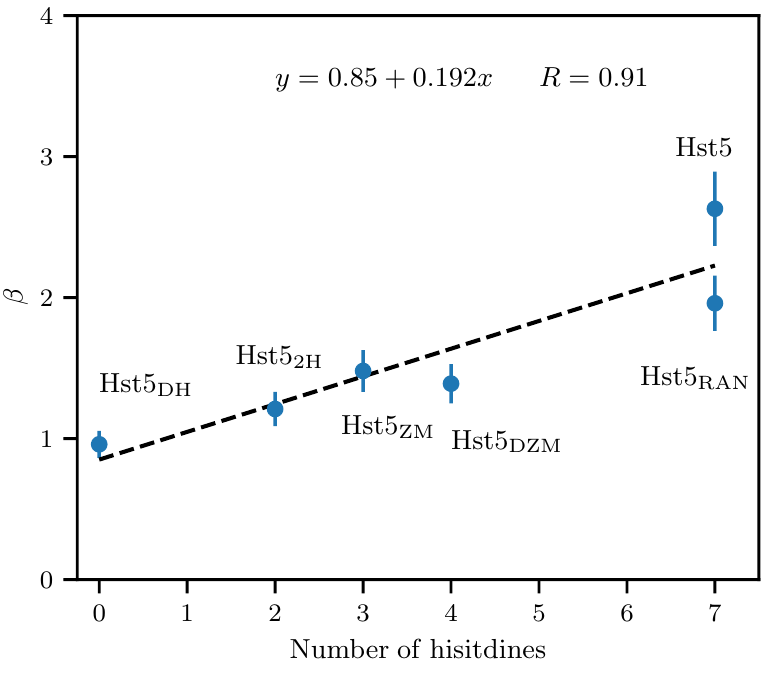
Figure 6. Correlation between the number of histidines and oligomerisation of Hst5 in the presence of Zn 2+ . The mass increase of the system defined as, β , see Equation (16), as a function of the number of histidines. Here β =1.0 indicates no mass increase in the system i.e., no oligomerisation, whereas β > 1